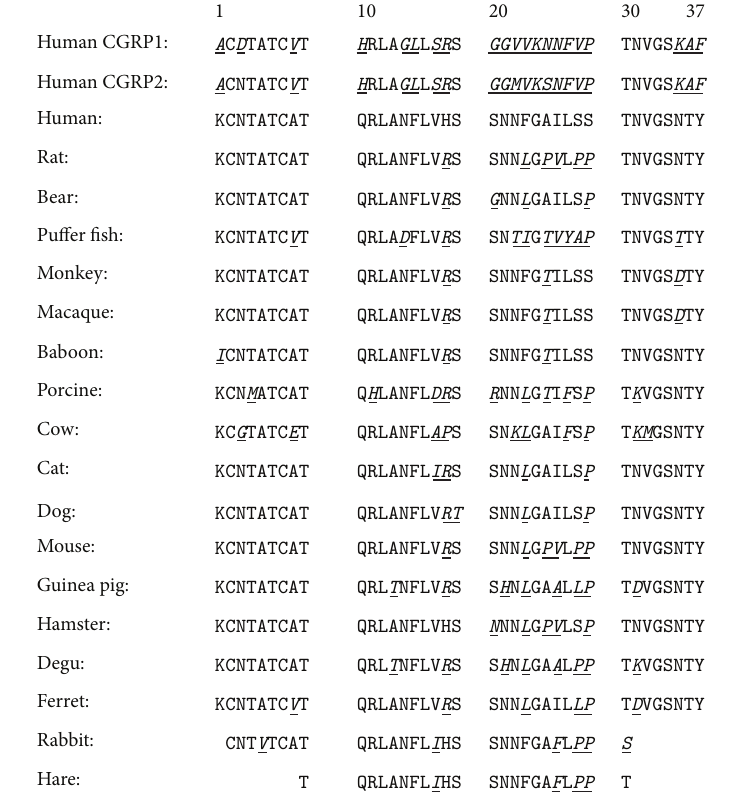
Figure 1: Primary sequences of human CGRP and of IAPP from different species. Residues that differ from the human IAPP sequence are in italics and underlined. The biologically active sequences all contain a disulfide bridge between Cys-2 and Cys-7 and have an amidated C- terminus. Primates and cats have been reported to form islet amyloid while, rodents, and dogs do not. Ferret and porcine IAPP are reported to besignificantlylessamyloidogenicthanhumanIAPP.Theabilityofcow,bear,andpufferfishIAPPtoformamyloidhavenotbeeninvestigated. Islet amyloid is found in the degu, a rodent, but it is derived from insulin, not from IAPP. Only partial sequences are available for rabbit and hare.